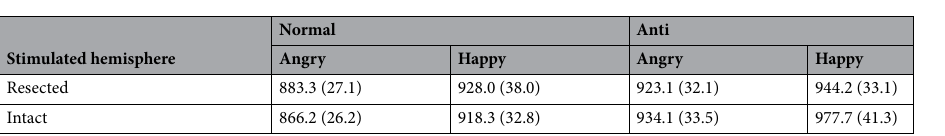
Table 1. Mean (± SE ) reaction times (ms) in the visual-search task in temporal-lobe-resected patients.